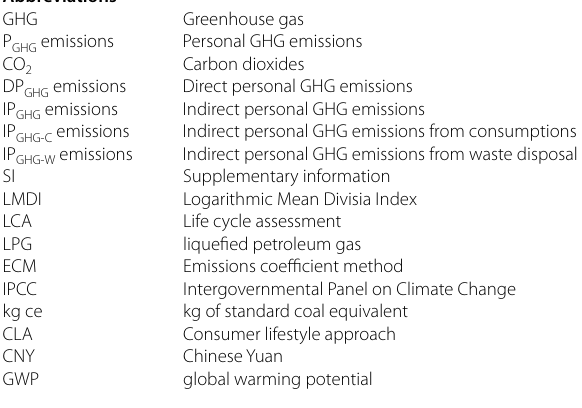
Additional file 1: Table S1. 100-year Global Warming Potential (GWP). Table S2. Emission factors for different MSW treatment technologies. Table S3. Overview of the studies on household or personal GHG emissions. Table S4. The household energy consumption per capita in Shanghai from 2010 to 2020. Table S5. The GHG intensity of different sectors from 2010 to 2020 (unit: t CO 2 /10 4 yuan). Table S6. The waste amount and treatment methods in Shanghai from 2010 to 2020 (unit: ten thousand tons). Table S7. The total population of Shanghai from 2010 to 2020 (ten thousand people). Table S8. The emission factors of the differ- ent fuel types. Table S9. The electricity emission factor from 2010 to 2020 (kg CO 2